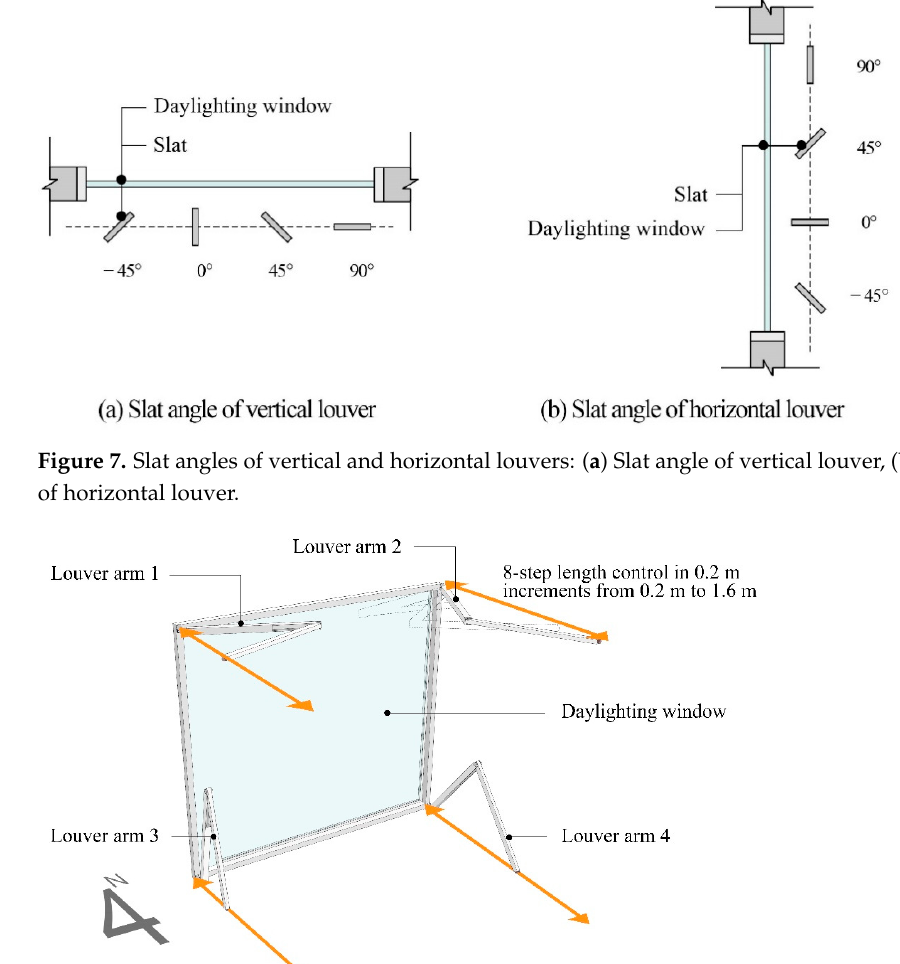
Figure 8. Louver arm control of the solar tracking-based movable louver (STML) .